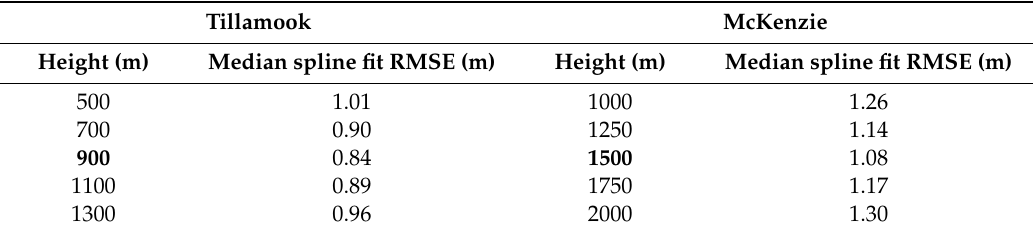
Table 4. Cubic spline fit error against recorded laser instrument positions for selected above ground heights. Height is used to calculate pulse weights that, in turn, determine the selection of time block pulses participating in the formulation of CPAs. The nominal height e ff ective for laser data acquisition in each study area is in bold. All swaths were used in the computations, with 3 s end trimming applied. Spline fit is represented as Root Mean Square Error